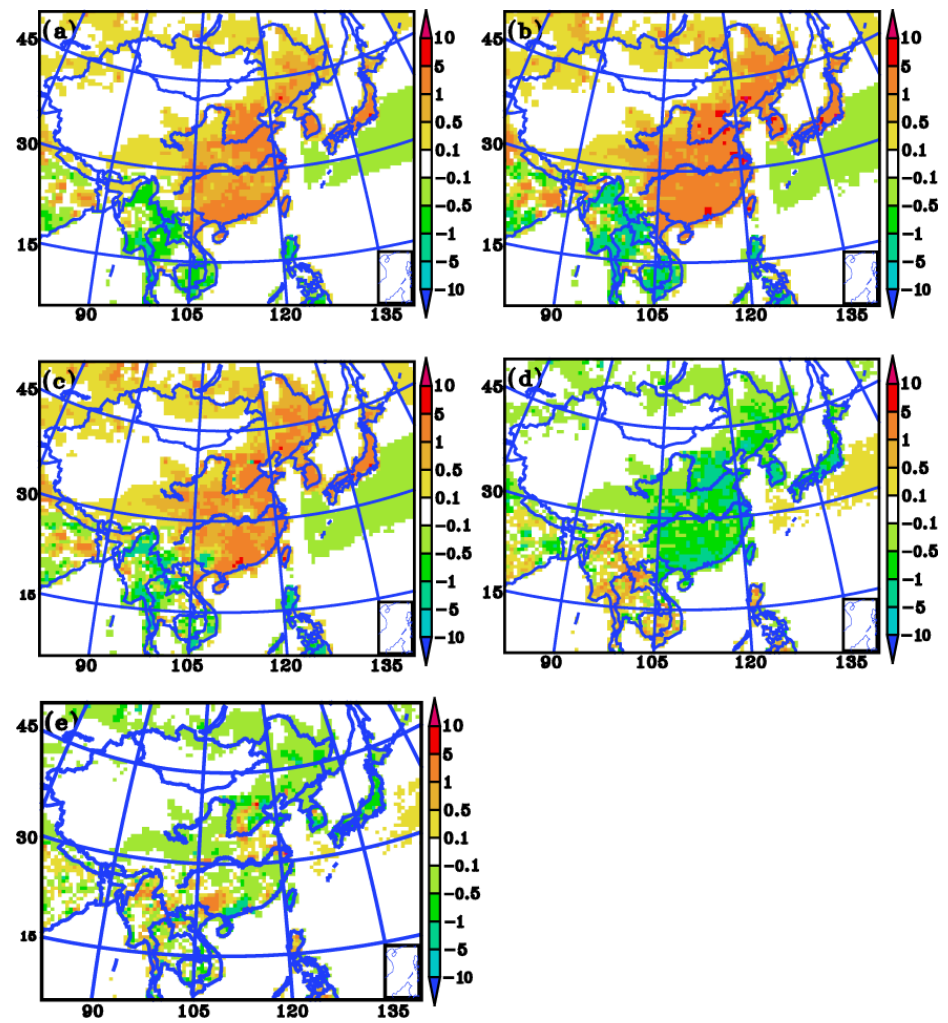
Figure 7. Monthly mean values in February 2010 of (a) F p t , the prior true surface CO 2 fluxes; (b) F ∗ t , the prescribed CO 2 surface fluxes, F ∗ t = ( 1 . 8 + δ(x,y,z,t)) F p t ; (c) F a t , the ensemble mean values of the assimilated surface CO 2 fluxes; (d) F p t − F ∗ t ; and (e) F p t − F a t (units: µmolem − 2 s − 1 ) . F a t are the assimilated results of a CFI-CMAQ OSSE, in which the lag-window was 9 days and β was 70. They are the same in Figs.